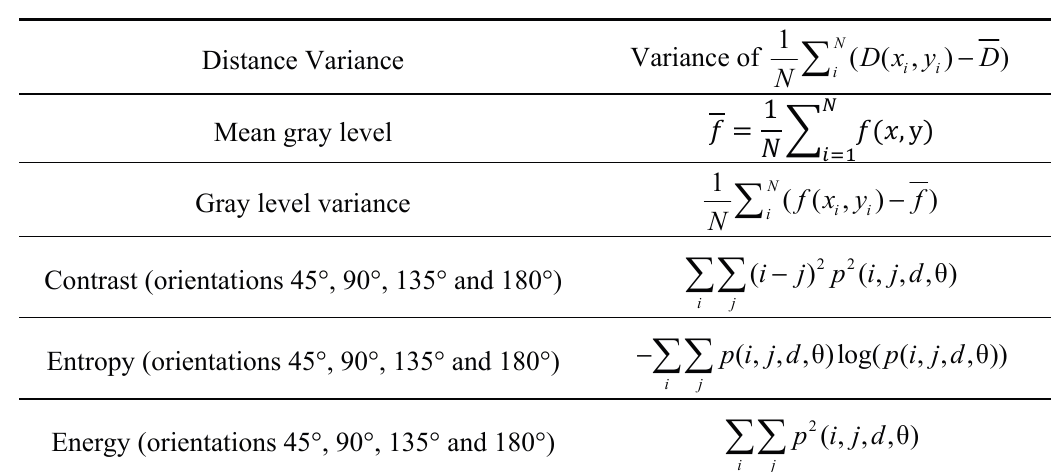
Figure 11. The structure of the back propagation neural network (BPNN) classifier. Table 1. Mathematical formulations of the